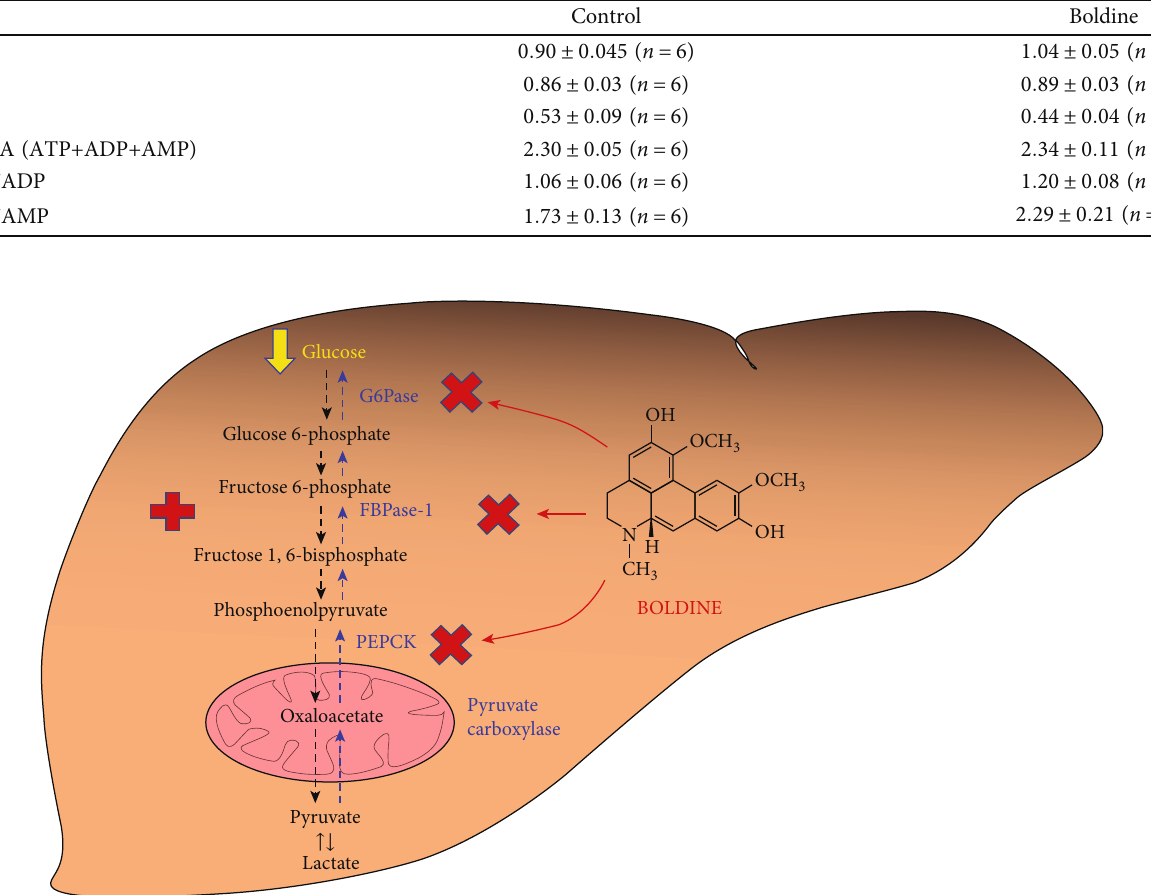
Figure 8: Schematic representation of the main sites of action of boldine on the pathways leading to glucose synthesis and degradation in the liver. The + sign denotes stimulation, and the x denotes